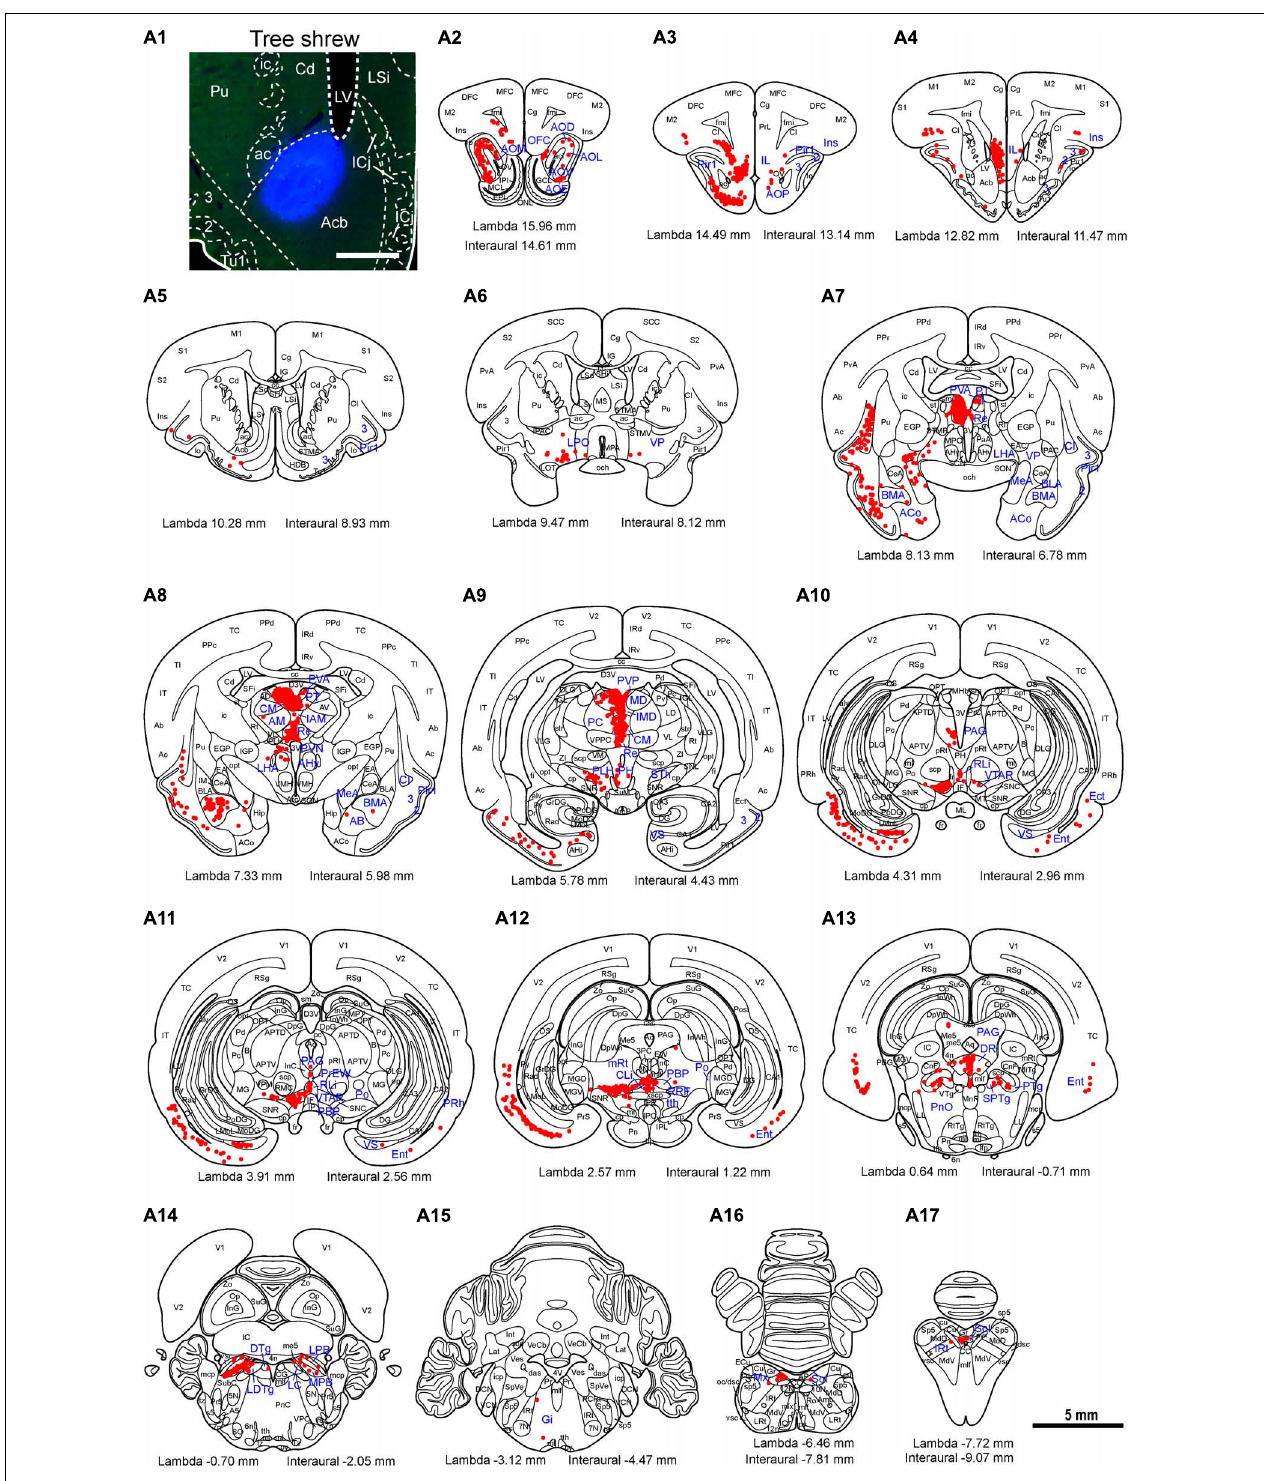
FIGURE 9 | Whole-brain mapping of afferent projections to the accumbens nucleus (Acb) in tree shrews. (A1) Photomicrograph showing the injection site of Fluoro-Gold (FG) retrograde tracer in the Acb of the tree shrew brain. The Acb was determined by staining with NeuroTrace 500/525-Green Fluorescent Nissl Stain (green). (A2–A17) Acb-projecting neurons (red dots) were present in the tree shrew brain (blue letters) from rostral to caudal. Representative coronal sections were selected from two tree shrew brains and referenced to lambda (distance indicated at lower left corner). The density of dots represents the relative density of projecting neurons in those areas. Each dot represents approximately one FG-labeled neuron. For abbreviations, see Abbreviations. Scale bars = 1 mm in (A1) ; 5 mm in (A2–A17) .